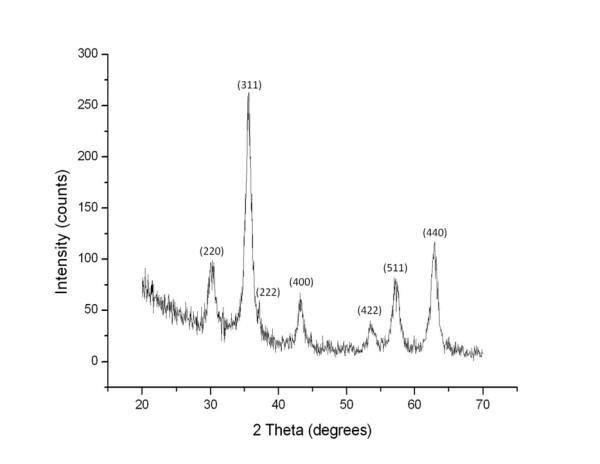
The crystalline phases of Fe3O4 nanoparticles.